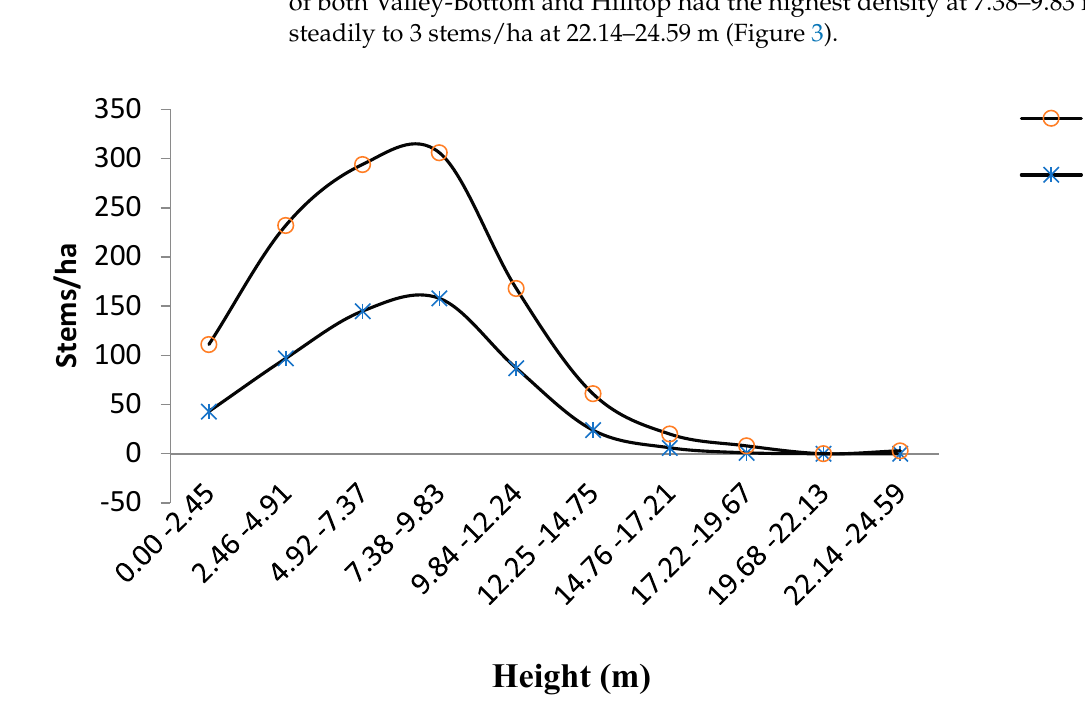
Figure 3. Height-density distribution of the Teak stand of the Valley-Bottom and Hilltop stands in the Omo Forest Reserve.